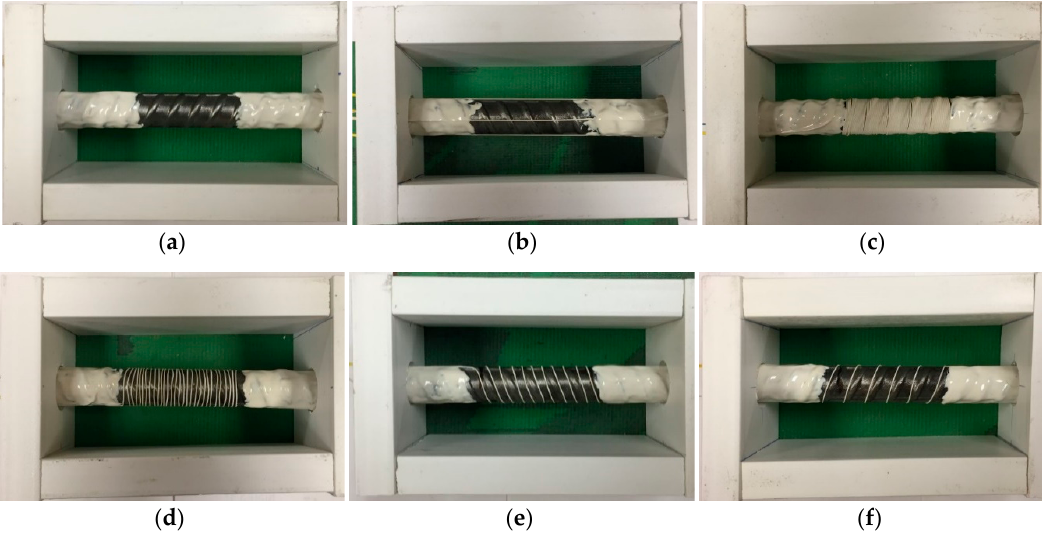
Figure 5. Steel bars in the beams for corrosion testing: ( a ) Ref; ( b ) L4; ( c ) S0; ( d ) S2; ( e ) S5; ( f ) S10.